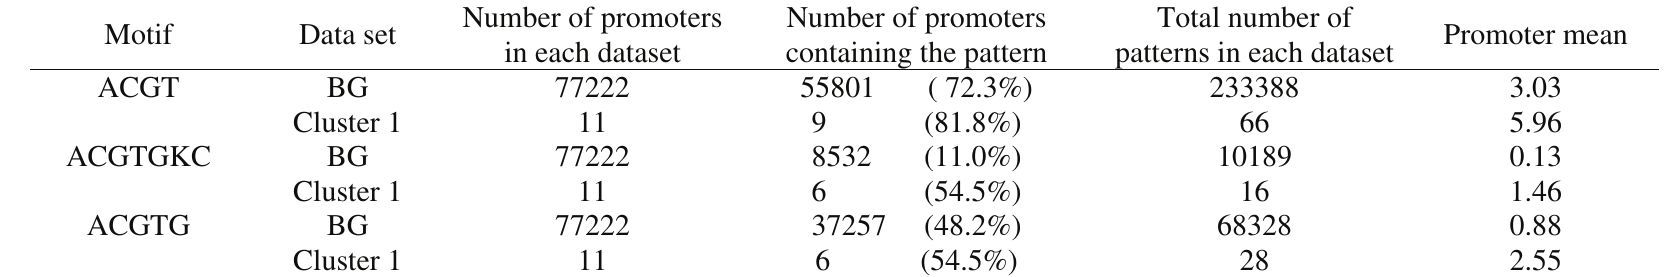
All analyzed promoter sequences presented 1,000 bp and POBO was run with the following parameters: number pseudoclusters 50 and length of the background promoter 1,000 bp, bootstrap 1,000. The symbol K was used in addition to A or T. Calculated t-test using the linked on line GrapPad web site: ttp://www.graphpad.com/quickcalcs/DistMenu.cfm; p